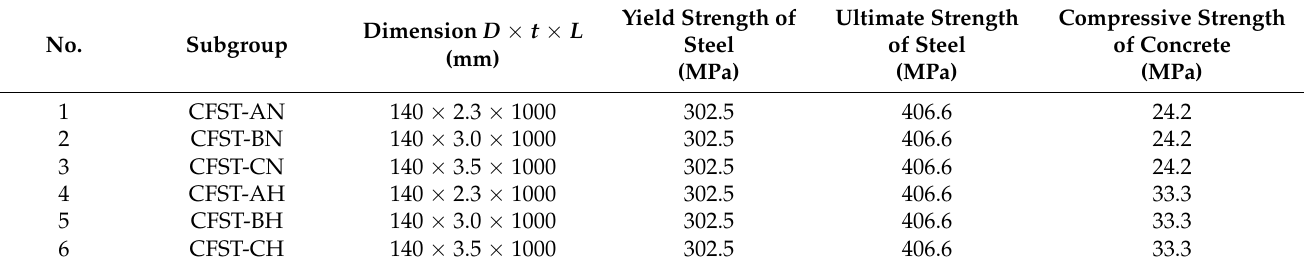
Table 1. Tested specimens (adapted from